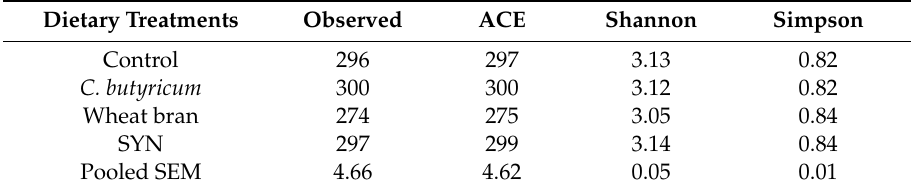
Table 5. Operational taxonomic units (OTUs) and diversity indices from cecal contents of broiler chickens (day 37 of life) 1